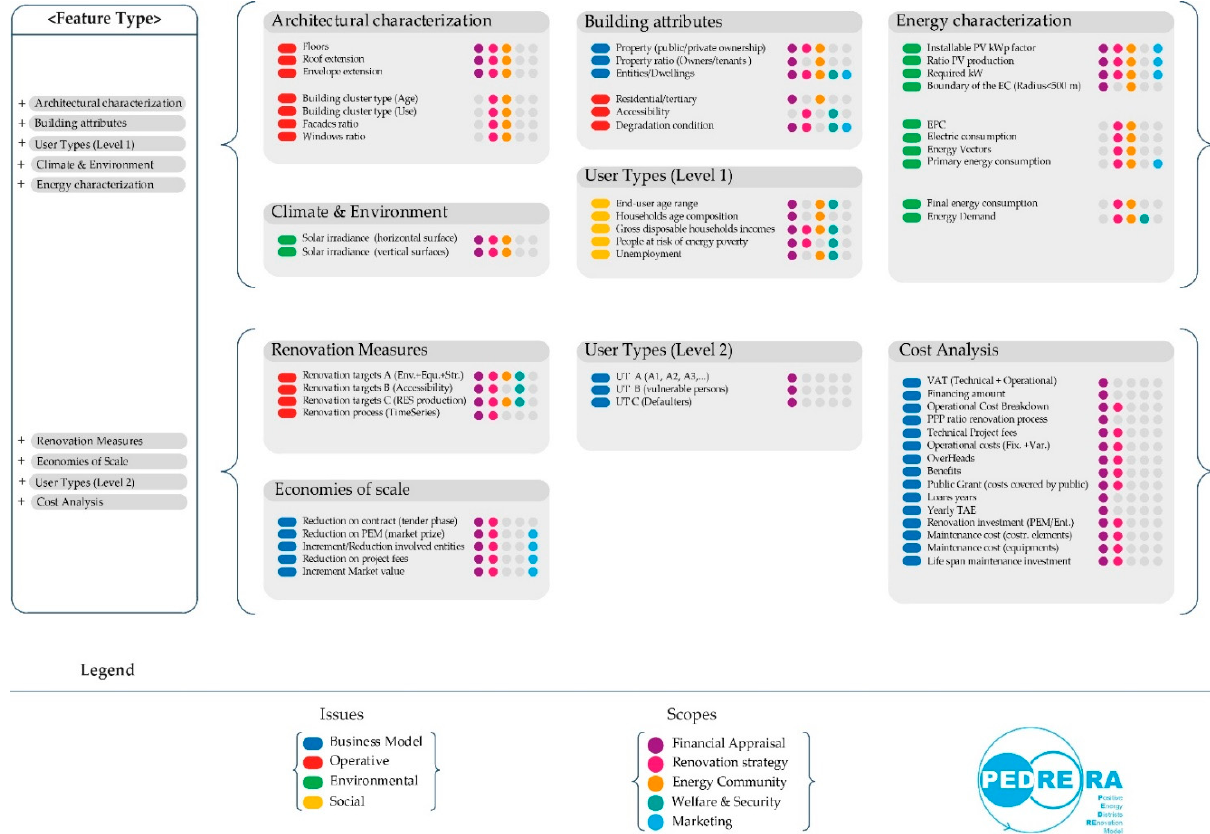
Table 2. List of main building archetypes implemented and managed in the PEDRERA model. Source: urbanZEB web